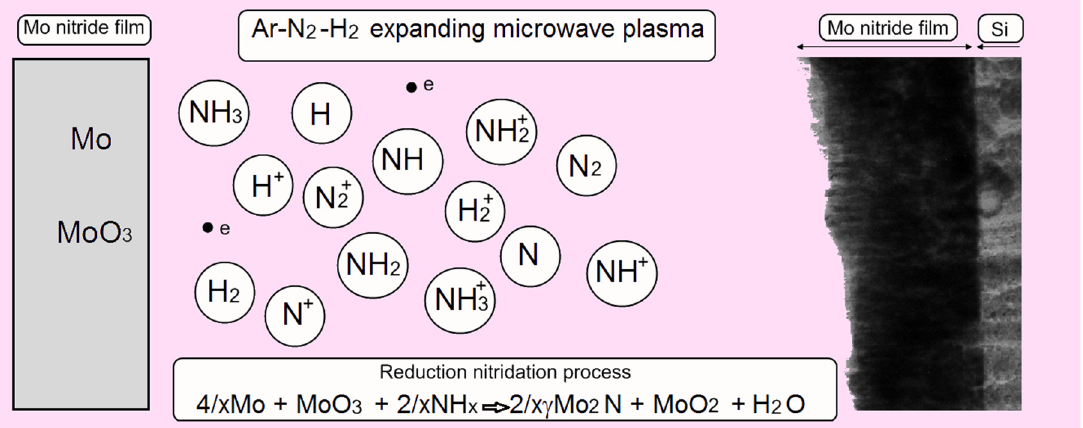
Figure 2. ( a ) X-ray diffraction pattern of molybdenum film 500 nm thick heated at 873 K and exposed to (Ar–33%N 2 –1%H 2 ) plasma for 30 min; ( b ) X-ray diffraction pattern of molybdenum film 800 nm thick heated at 873 K and exposed to (Ar–33%N 2 –1%H 2 ) for 1 h; ( c ) X-ray diffraction pattern of molybdenum film 1 μ m thick heated at 873 K and exposed to (Ar–33%N 2 –1%H 2 ) for 1 h [55]. Copyright Elsevier 2015.